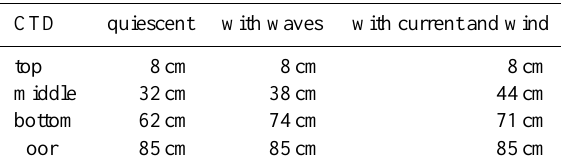
Table 1. CTD sensor depths during the different general